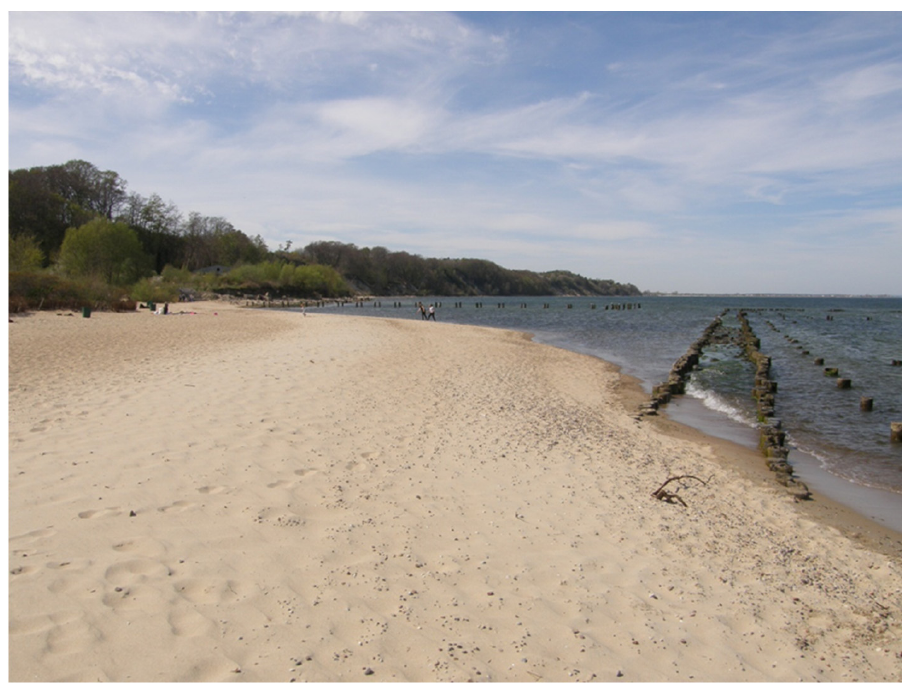
Figure 4. Seashore near KM 93.4–93.5; view to the north; sea state: 501 cm; 13.00 UTC, 10 May 2021 (photo by R. Ostrowski).